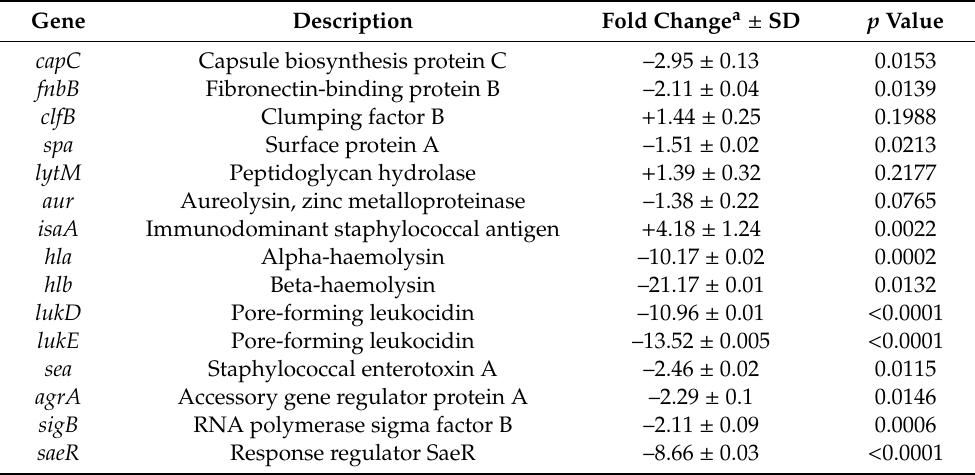
a —indicates reduction and + indicates